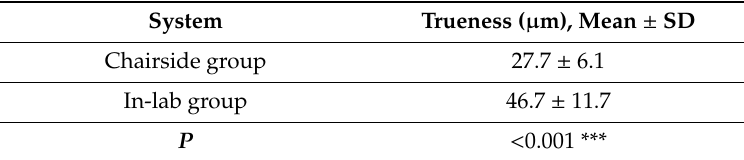
Table 2. Comparison of the trueness values according to digital workflows.